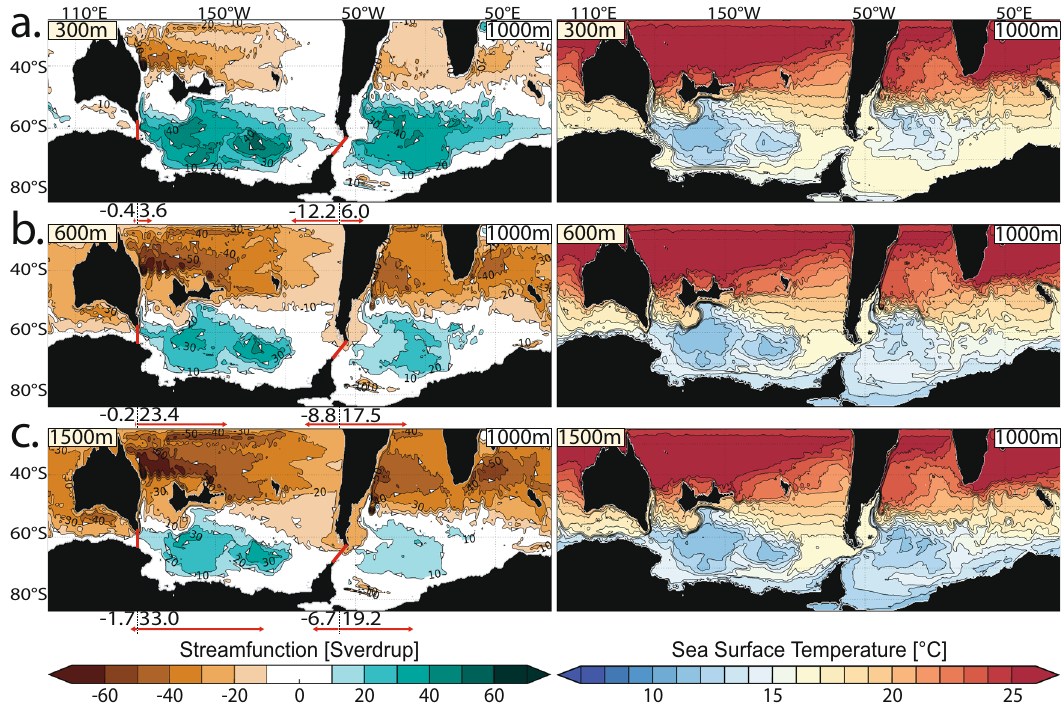
Fig. 2 Impact of gateway deepening on Southern Ocean circulation and temperature. Oceanographic model results from progressive deepening of the Tasmanian Gateway (TG) from: a 300 m to b 600 m and c 1500 m water depths, with an already deep second gateway (Drake Passage (DP), 1000 m). See supplementary data for constant deep TG and progressively deepening DP. Left-hand side panels: ocean circulation patterns (annual mean and depth integrated stream function with contours indicating 10 Sverdrup intervals, white arrows indicate the fl ow direction). The zonal volume transport in east- and westward direction through both gateways (red lines) are indicated as red arrows and values in Sverdrup. Right-hand side panels: annual mean sea- surface temperatures (at 100 m water depth) with contours indicating 1 °C intervals. Black regions are above sea